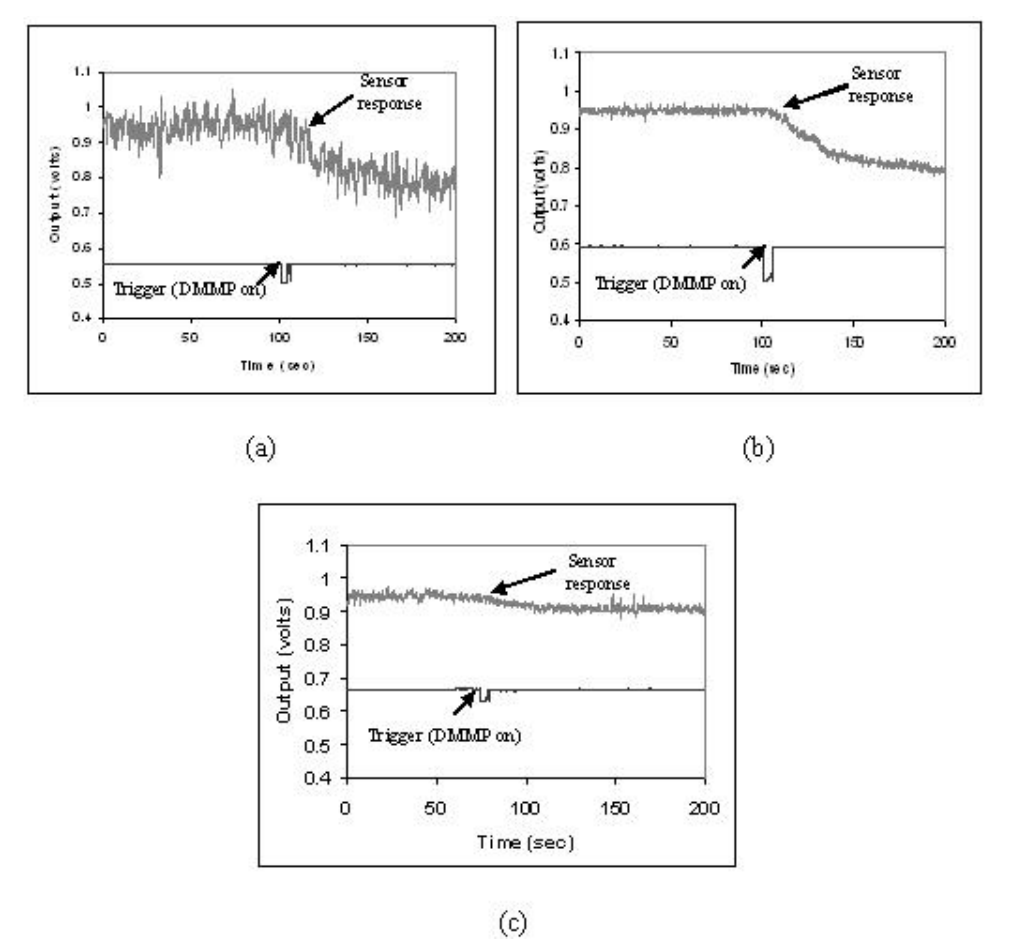
Figure 16. Sensor Response of Doped Polypyrrole for (a) HCL, (b) NDSA, and (c) ASQA